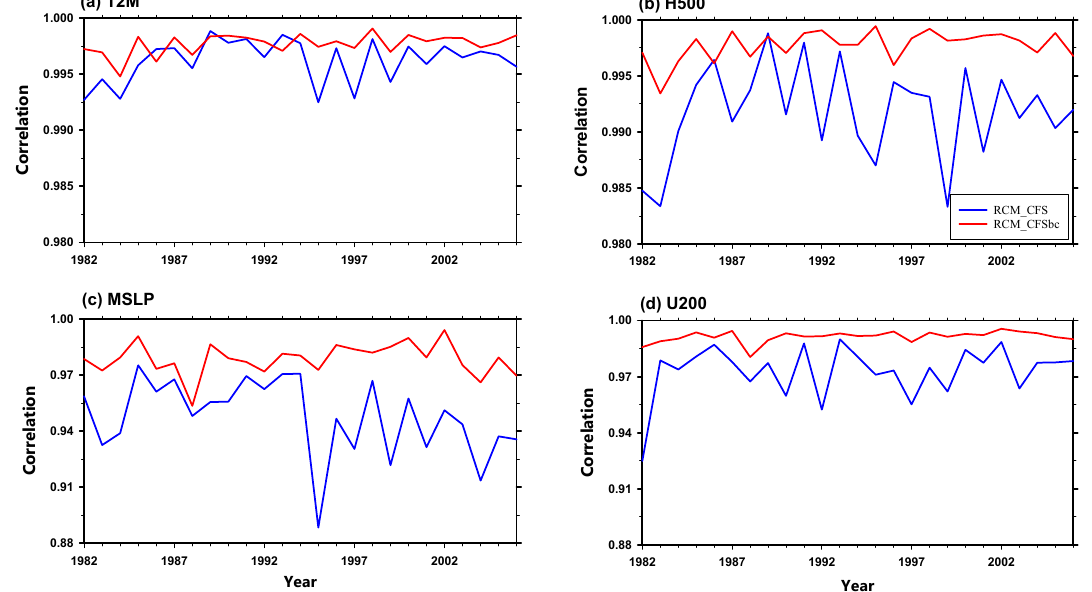
Figure 6. Time series of pattern correlation between RCM_R2 and RCM_CFS (blue line), RCM_CFSbc (red line) experiment for ( a ) 2 m temperature, ( b ) 500 hPa geopotential height, ( c ) mean sea level pressure, and ( d ) 200 hPa zonal wind.